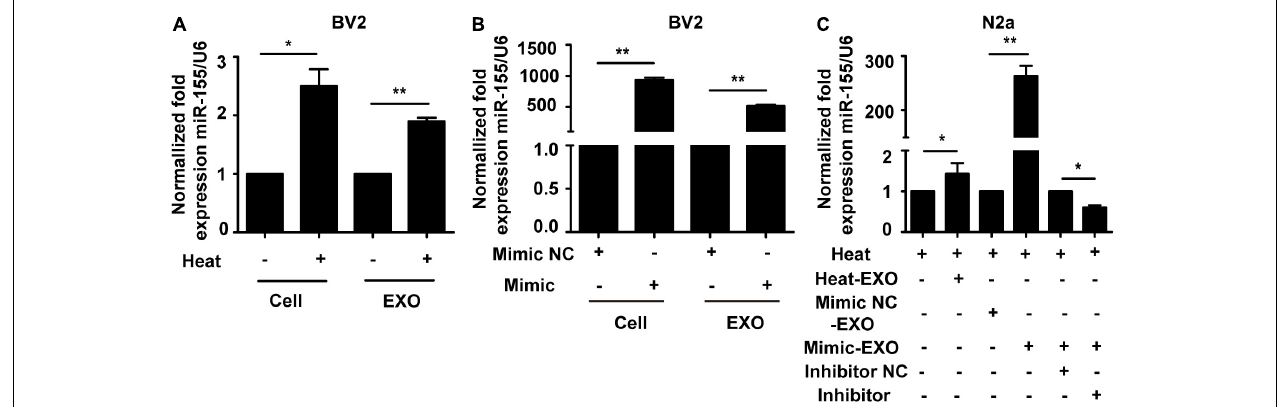
FIGURE 4 | Incubation with microglial exosomes increases miR-155 expression in N2a cells. (A) BV-2 cells were incubated at 37 ◦ C (control) or were subjected to heat stress at 42 ◦ C for 2 h, followed by a recovery period at 37 ◦ C for 6 h. The expression of miR-155 in BV-2 cells and exosomes was measured by qRT-PCR and normalized to U6 expression. (B) BV-2 cells were transfected with miR-155 mimic or miR-155 mimic negative control for 24 h, and then miR-155 expression in BV-2 cells and their exosomes was measured by qRT-PCR and normalized to U6 expression. The results are presented as the fold change with respect to the negative control. (C) N2a cells were pretreated with or without miR-155 inhibitor or its negative control and then incubated with exosomes (50 µ g/ml) derived from BV-2 cells that were subjected to heat stress, miR-155 mimic, or miR-155 mimic negative control transfection. Afterward, the cells were subjected to heat stress at 42 ◦ C for